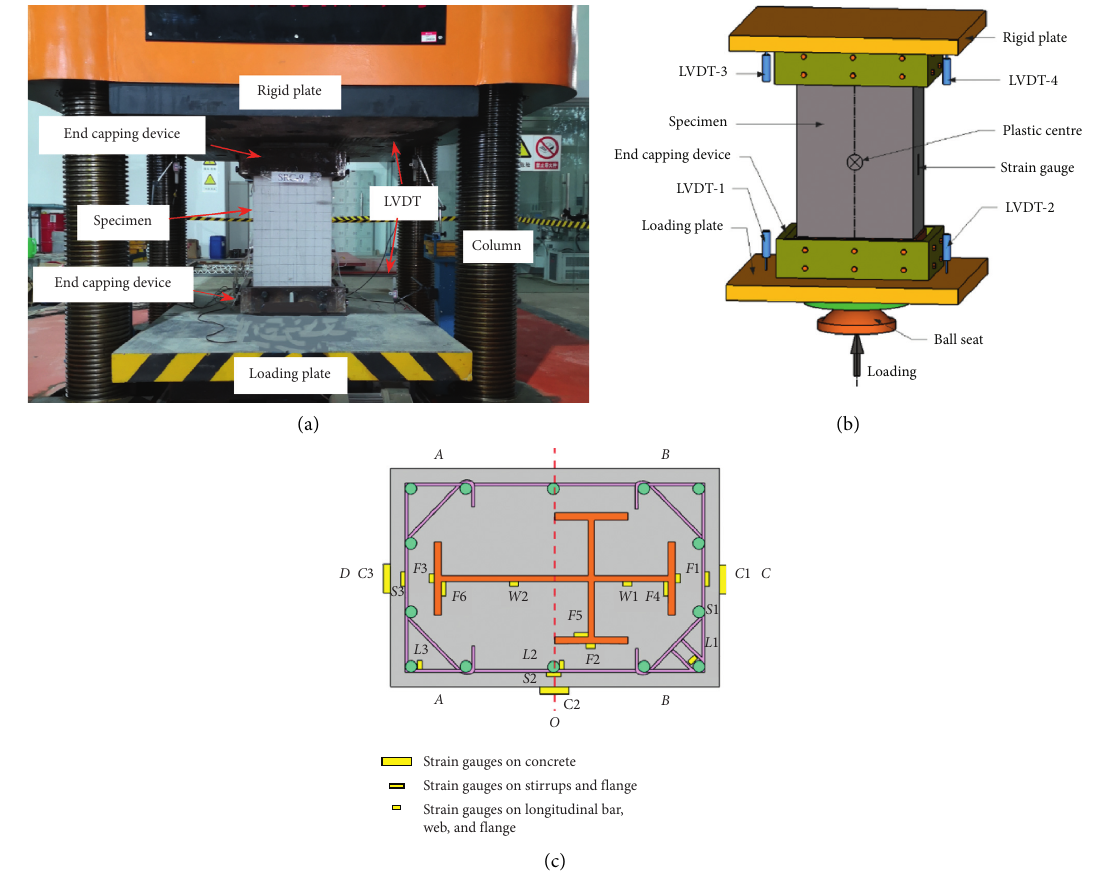
Figure 3: Test setup and instrumentation: (a) photograph of test setup, (b) test setup and layout of LVDTs, and (c) layout of the strain